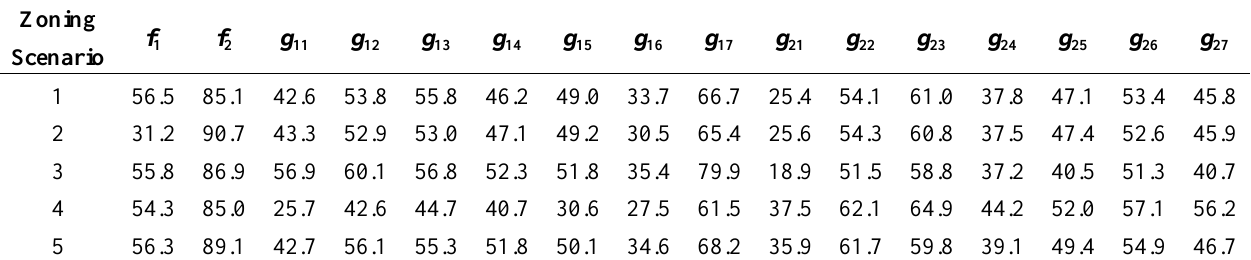
Table 8. Achieved fitness values (%) of the objectives under different zoning scenarios.